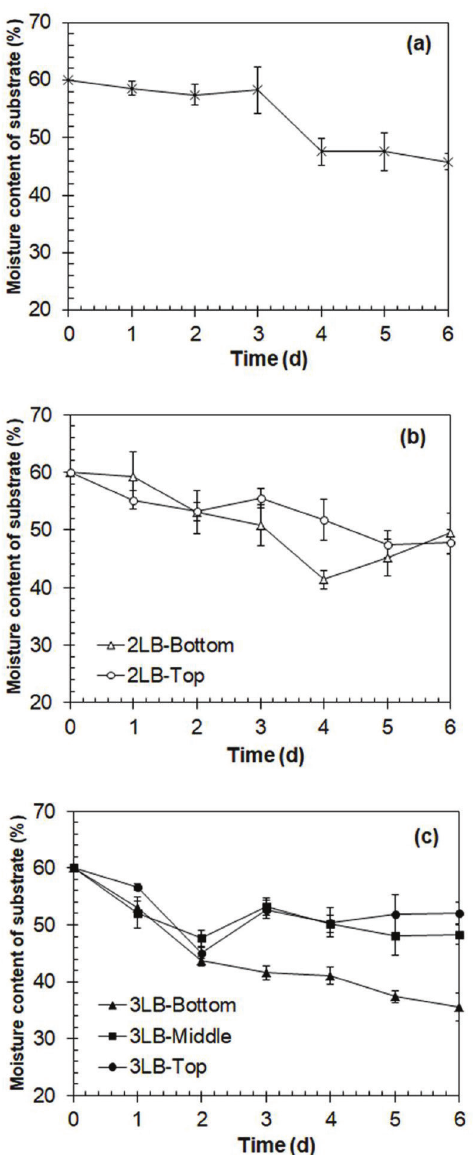
Fig. 3 – Glucosamine contents in fermented substrate. The glucosamine contents represent the fungal growth (a) Control packed-bed bioreactor, cB; (b) Two-layered packed-bed biore - actor, 2lB; (c) Three-layered packed-bed bioreactor, 3lB.